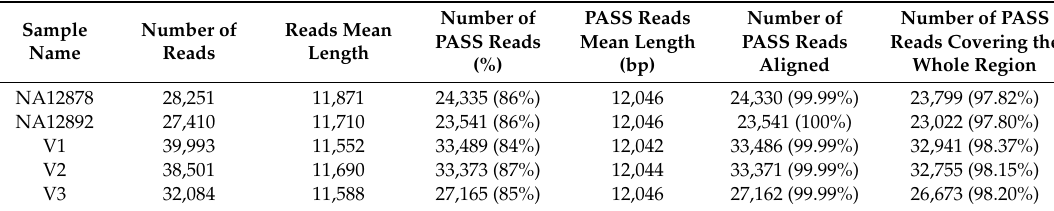
Table 3. ONT sequencing statistics. The total number of ONT reads and the number and percentage of PASS reads, along with the read length of each